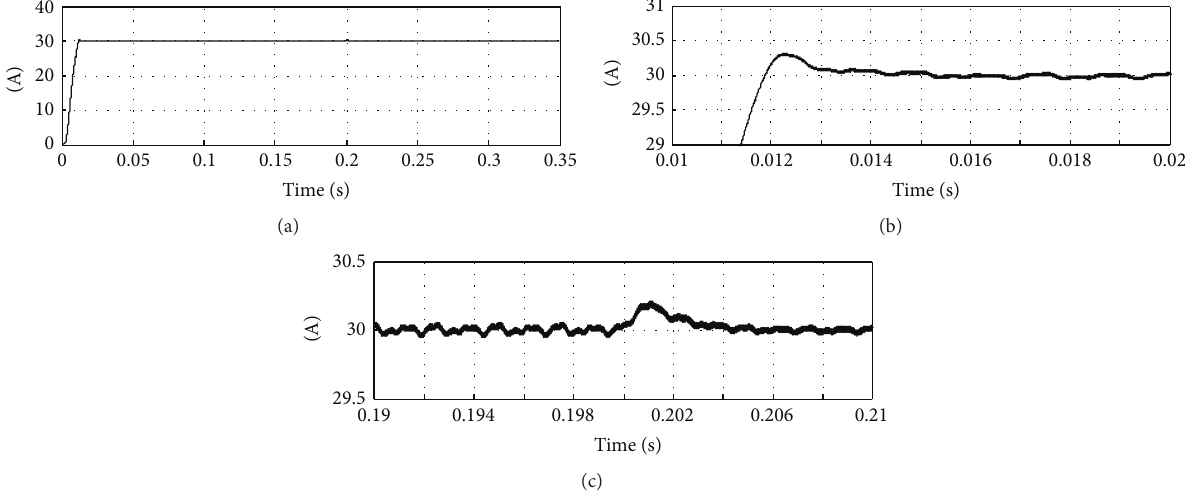
Figure 8: Simulation of buck-converter with constant current loads.